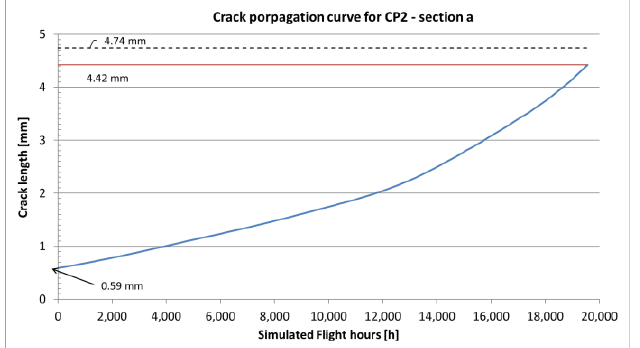
Figure 10. Crack propagation curve and inspection intervals definition for section a of CP2.